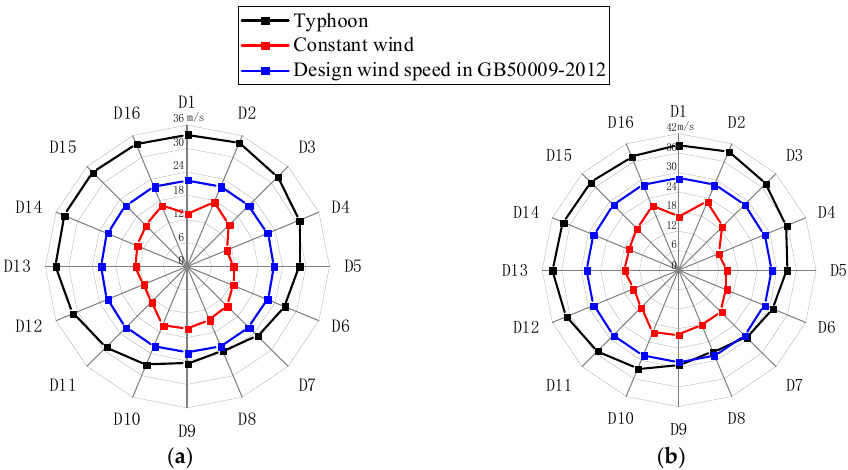
Figure 15. Comparison of the extreme wind speed with the design wind speed given by the code in Ningbo. ( a ) Ten-year return period. ( b ) Fifty-year return period.